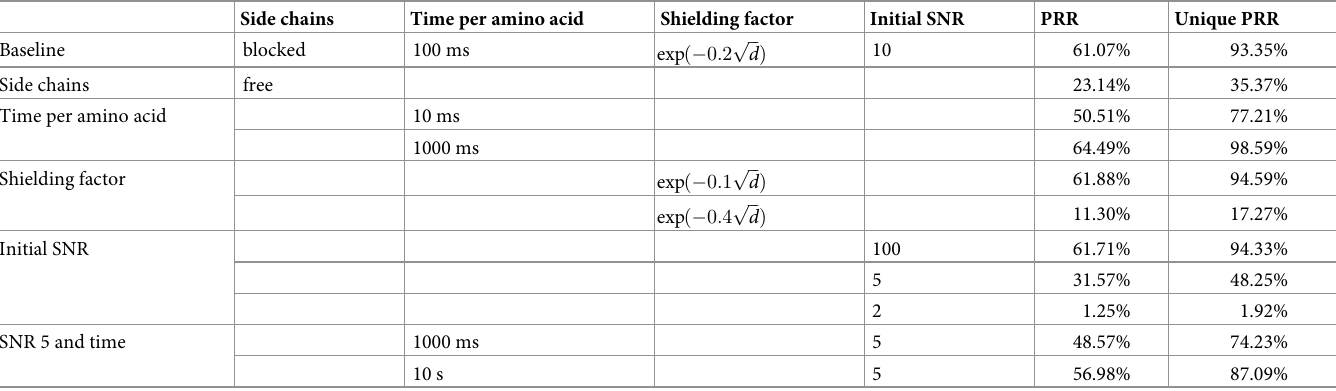
Table 2. Overview of Proteome Recovery Rates (PRR) for different simulation